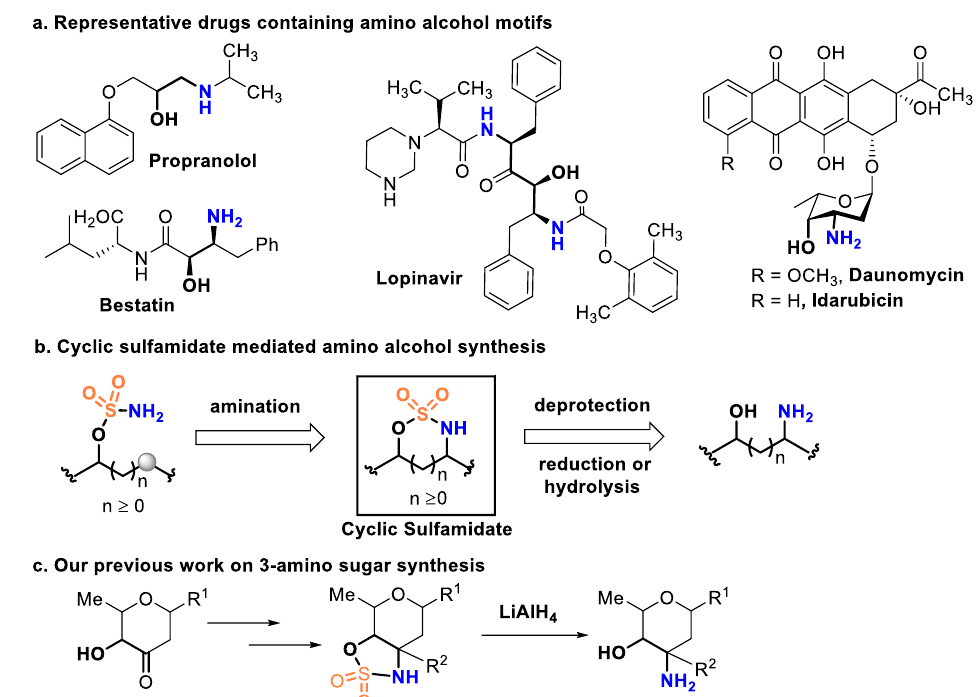
Figure 1. Representative drugs containing amino alcohol motifs and established approaches to synthesizing amino alcohols.